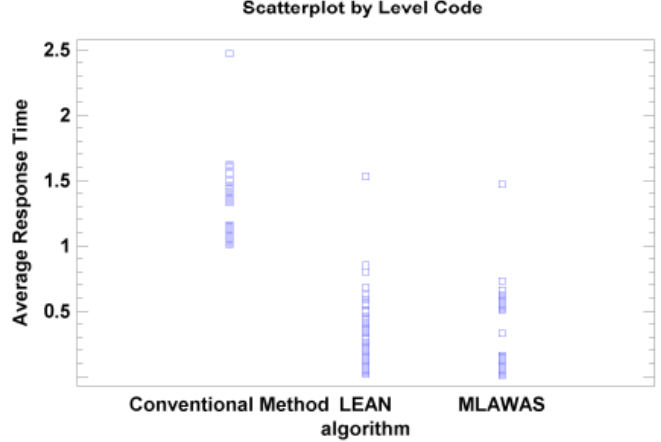
Figure 14. Average Response Time of Workload Without Migration